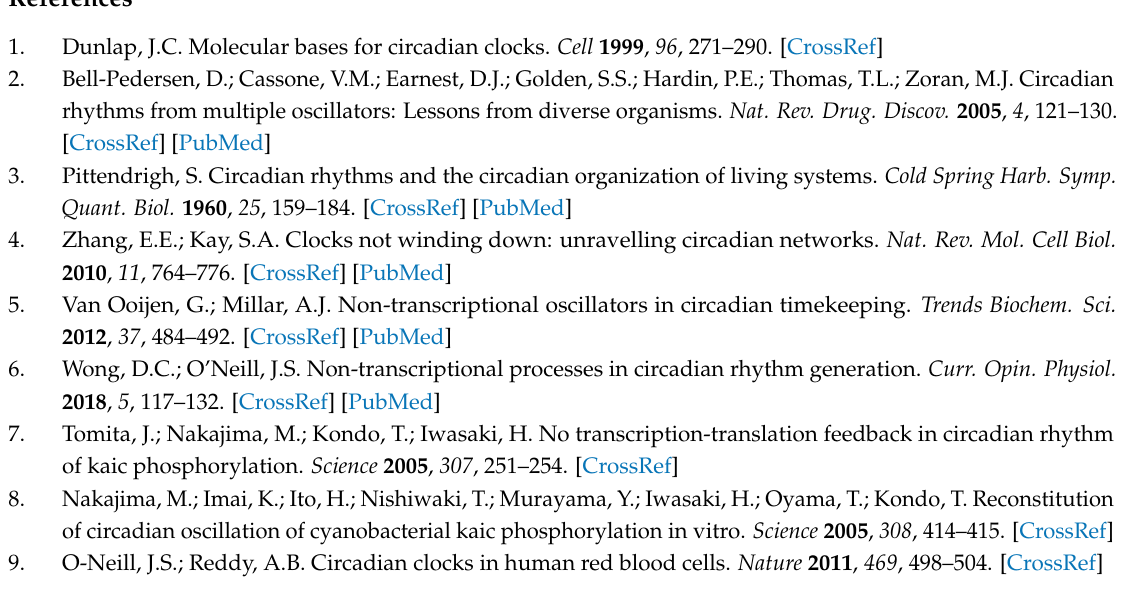
Figure S1: (a) The Ot MgtE MgtE domain shares homology with the bacterial MgtE domain (here from Thermus thermophiles ) and all three human SLC41 proteins as shown with this multiple sequence alignment. The two conserved motifs outlined by Wabakken et al. (2003) are shown in green. “*” denotes a fully conserved residue, “:” denotes conservation between groups of strongly similar properties and “.” denotes conservation between groups of weakly similar properties. (b) The hydrophobicity plot predicting transmembrane domains indicates that this protein is a transmembrane protein. Figure S2: Luminescent traces and period analysis of Ot MgtE